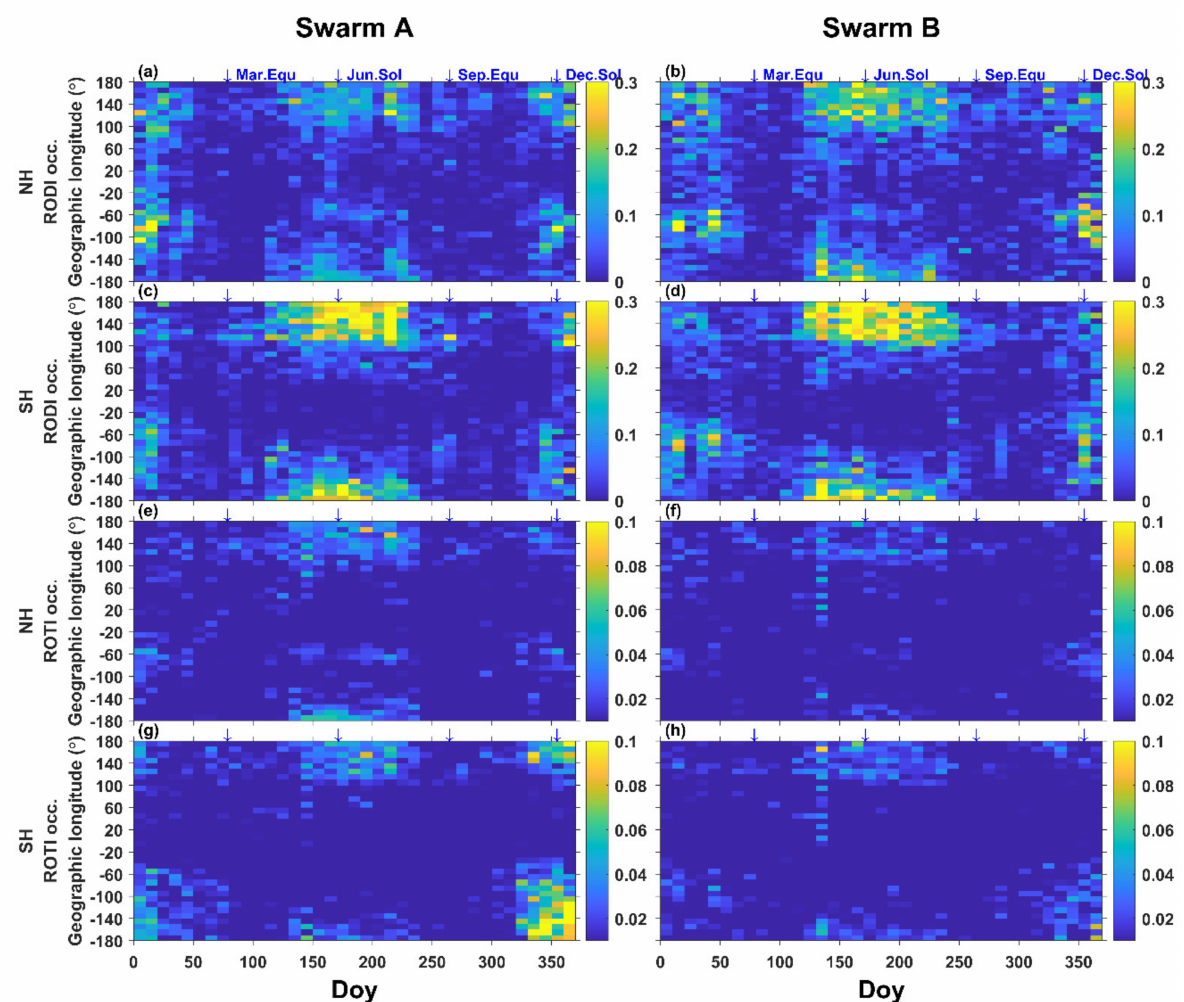
Figure 12. Variations of the plasma irregularity occurrence rate by RODI and ROTI as a function of Doy for different satellites at middle latitudes during Doy 0–360, F107 < 100. The panels from top to bottom show results for RODI occurrence in northern hemisphere ( a , b ), RODI occurrence in southern hemisphere ( c , d ), ROTI occurrence in northern hemisphere ( e , f ), and ROTI occurrence in southern hemisphere ( g , h ), from left to right show results for Swarm A and Swarm B. Note that in order to distinguish peak values in different periods, color-bar ranges for irregularities and scintillation occurrence are set